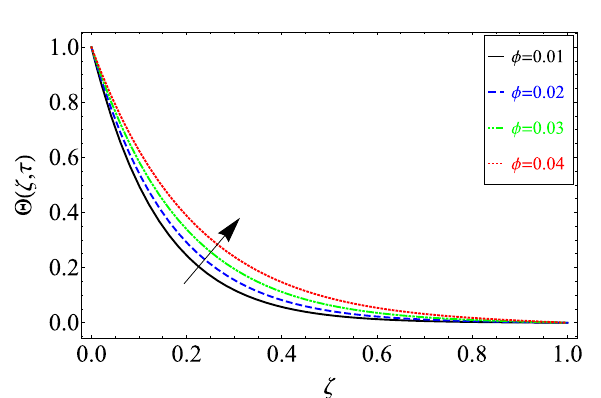
Figure 10. The effect of different values of φ on Temperature distribution of Maxwell nanofluid, when α = 0.7 and Pr = 6300